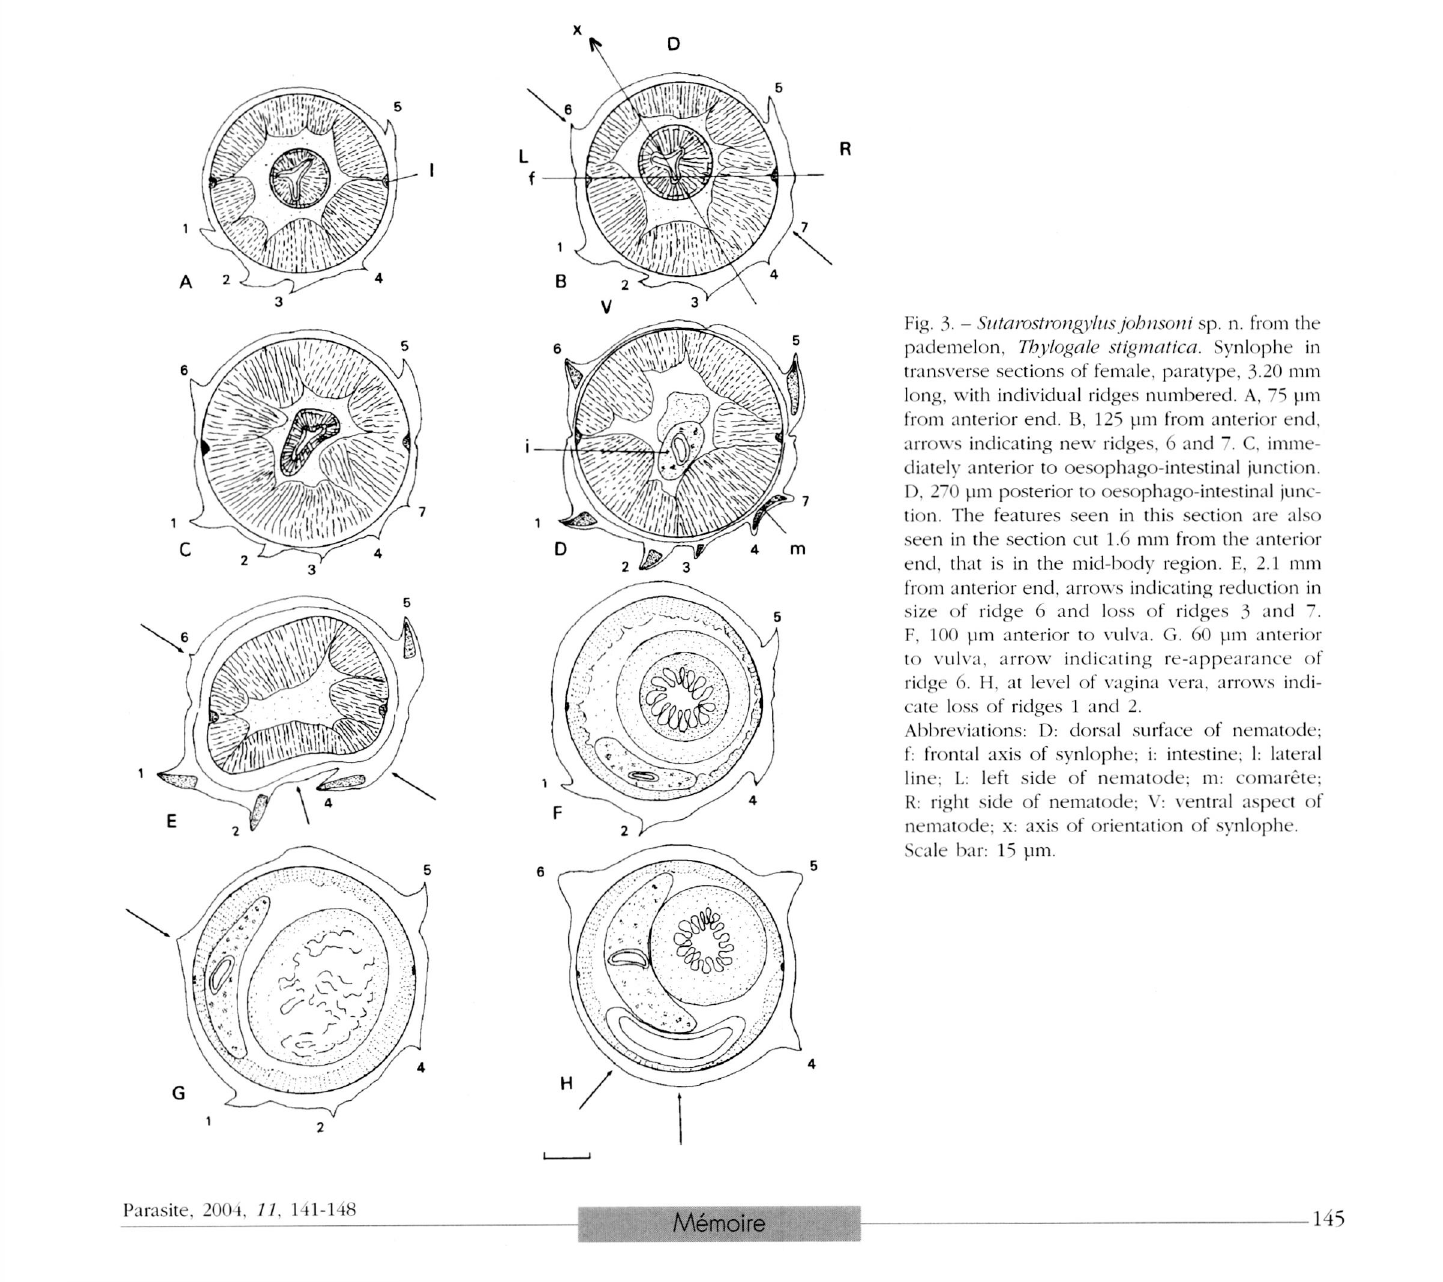
Fig. 3. ̶ Sutarostrongylus johnsoni sp. n. from the padcnielon. Thylogale stigmatica. Synlophe in transverse sections of female, paratype, 3.20 mm long, with individual ridges numbered. A. 75 μm from anterior end. B, 125 μm from anterior end, arrows indicating new ridges. 6 and 7. C. imme­ diately anterior to oesophago-intestinal junction. D, 270 pm posterior to oesophago-intestinal junc­ tion. The features seen in this section are also seen in the section cut 1.6 mm from the anterior end. that is in the mid-body region.